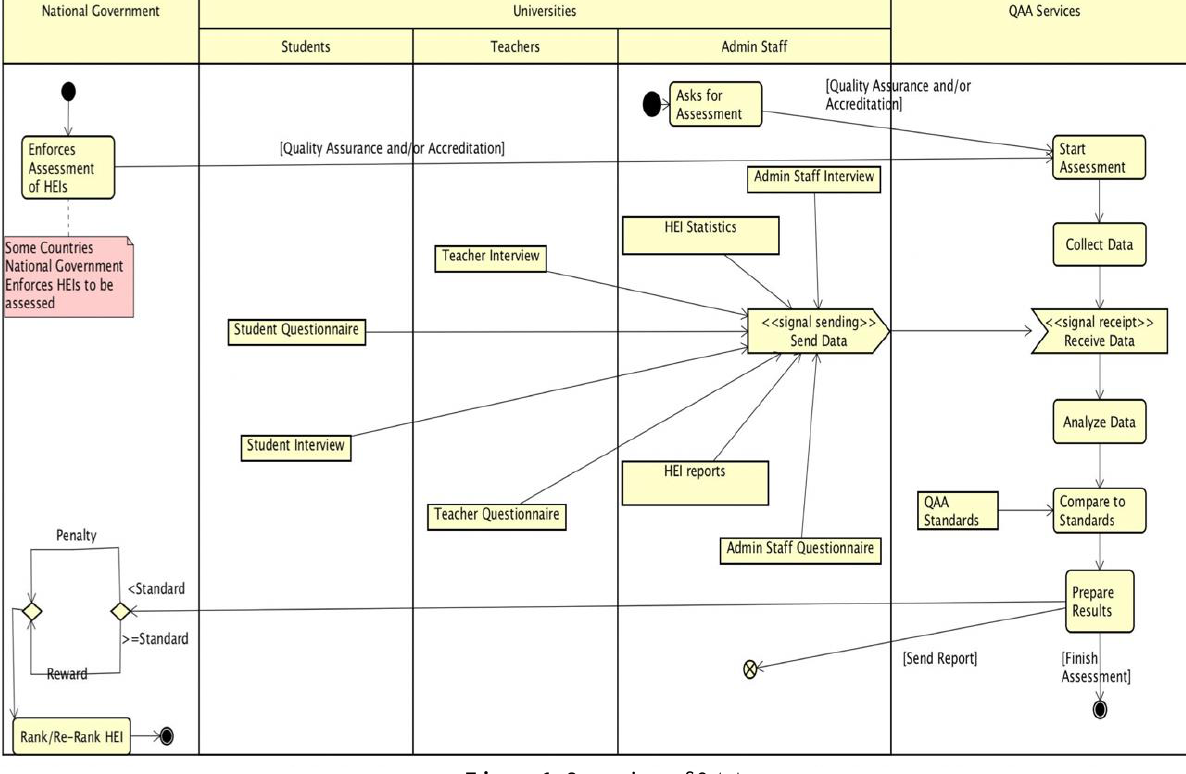
Figure 1 . Overview of